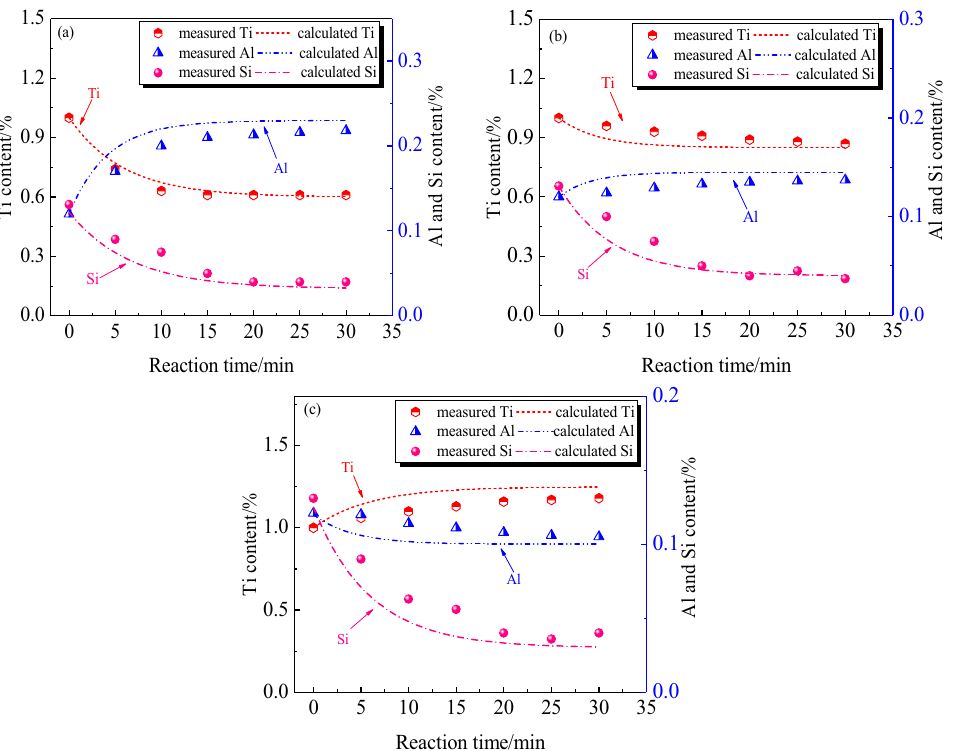
Figure 3: Experimental and calculated results of the content of Al, Ti, and Si in the alloy: ( a ) 3.57% TiO 2 , ( b ) 7.27% TiO 2 , ( c ) 11.27% TiO 2 .